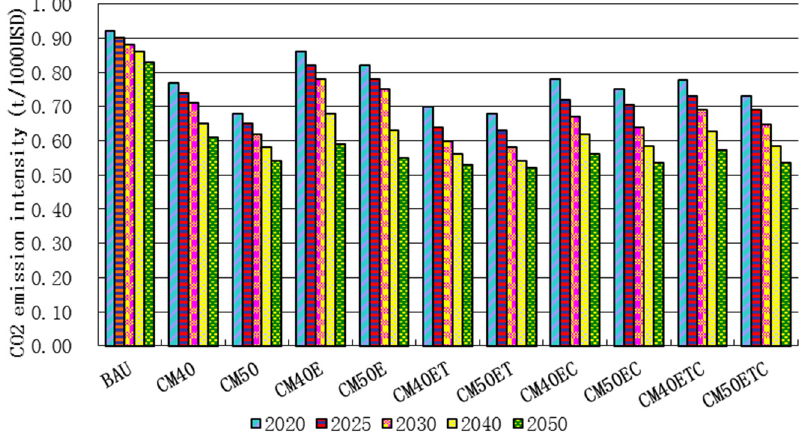
Figure 3. CO 2 emission intensity from 2020 to